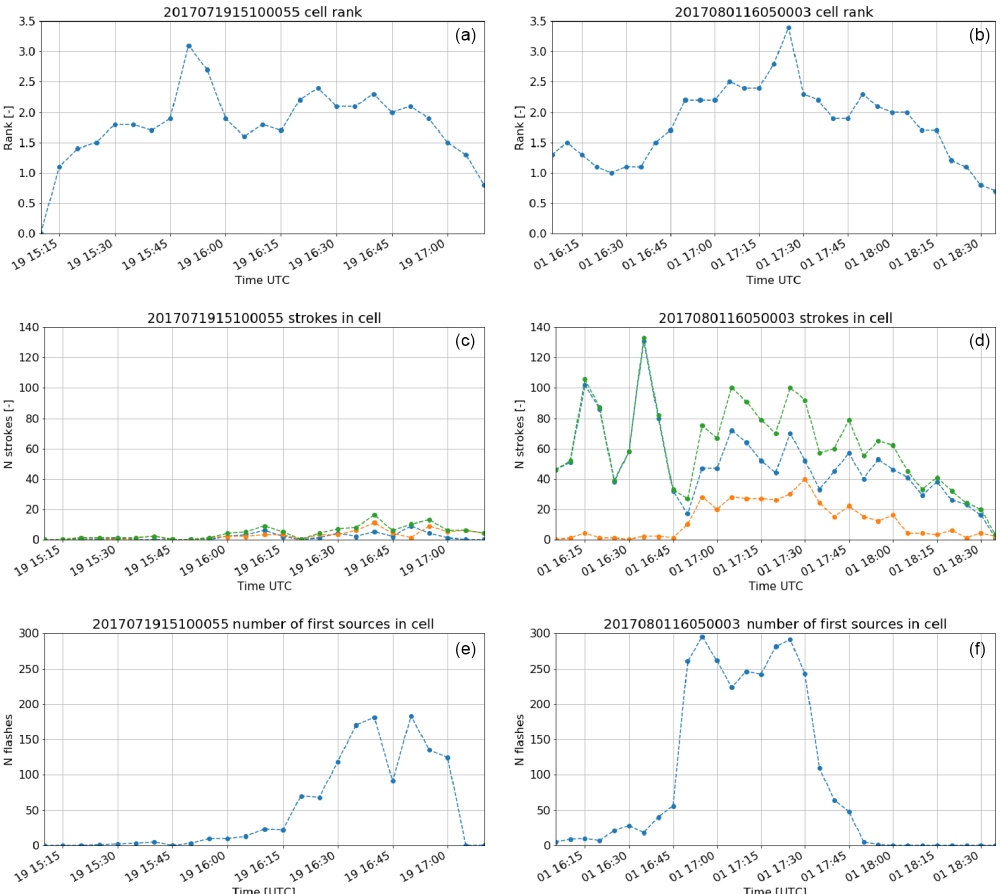
Figure 11. (a–f) Cell rank, EUCLID CG strokes (orange: positive; blue: negative; green: total) and LMA-detected flashes. (a, c, e) Cell 1; (b, d, f) cell